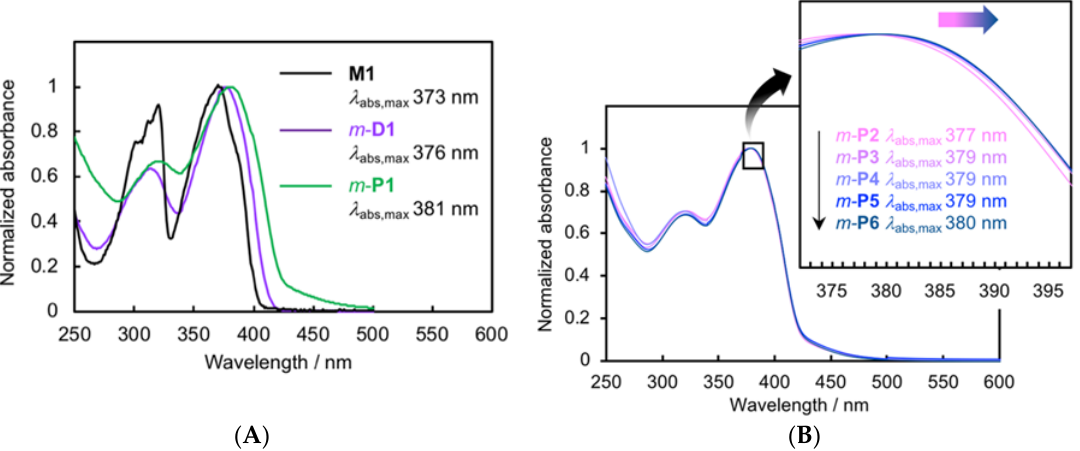
Figure 3. ( A ) UV-vis absorption spectra of M1 , m - D1 , and the soluble part of m - P1 in CHCl 3 (1.0 × 10 –5 M for M1 and m - D1 , and 0.84 × 10 –5 M for m - P1 ); ( B ) UV-vis absorption spectra of m - P2 – P6 in CHCl 3 .